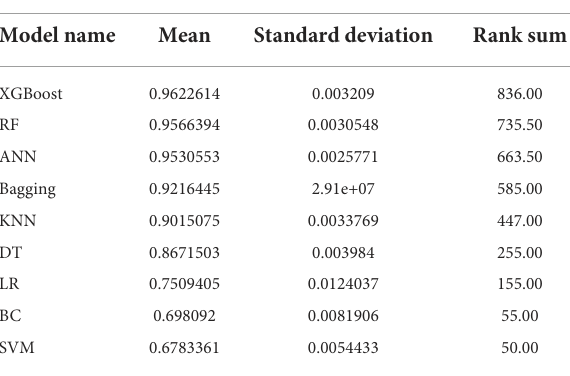
TABLE 6 Statistical tests of our nine models.